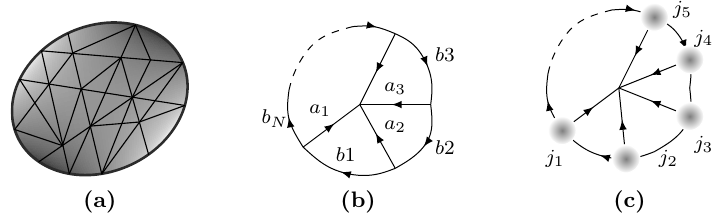
Figure 1. (a) An arbitrary triangulation of a disk. (b) A reduced triangulation of the disk. The labels refer to group elements. (c) Same graph as (b) with however labels referring to quasiparticles, i.e., representations of the group